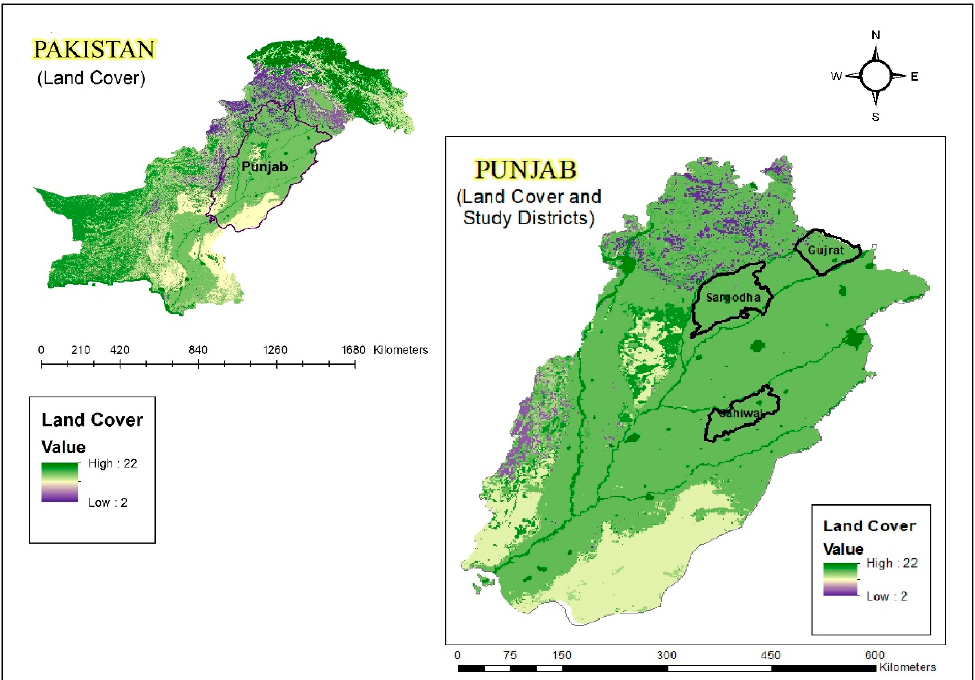
Figure 1. The location map of the study area and sample districts.